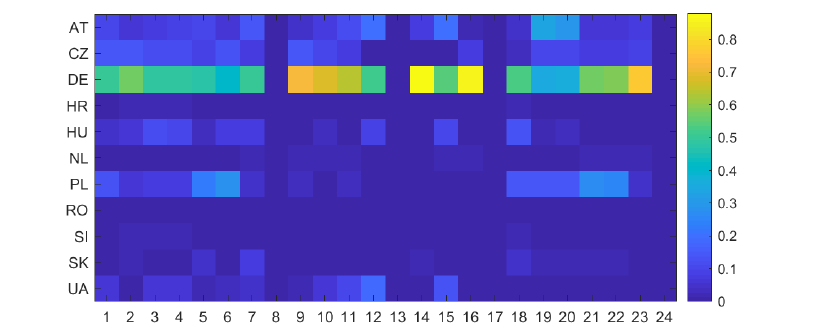
Figure 5. Zonal fractional shares averaged over all congested network elements with the highest overload.